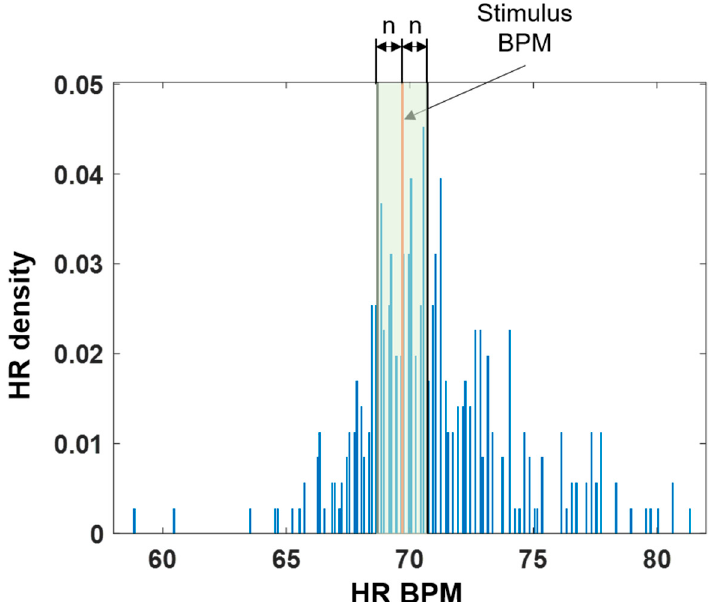
Figure 3. Example of a heart rate density distribution from subject 1 under the − 3% stimulation condition at an n of 2.0. The stimulus BPM was computed on the basis of the mean HR calculated over the previous 5 min. Orange line: position of the stimulus BPM. Shaded green: area of the densities between stimulus BPM ± n BPM, n = 0.5, 1.0, and 2.0 BPM.